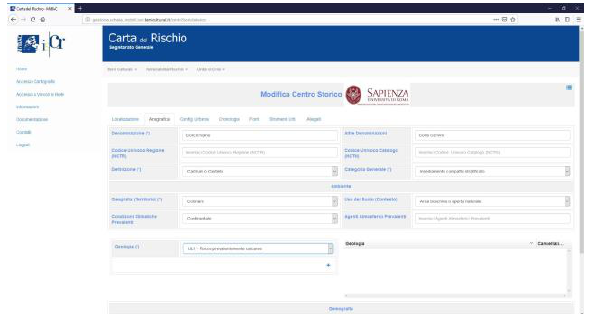
Figure 2. Risk Map: a sector of the report model concerning the identification record of the historical centre of Concerviano Figure 1. Risk Map: the historical center of Concerviano (Rieti) geoferred on the Satellite map with the general info of the database.